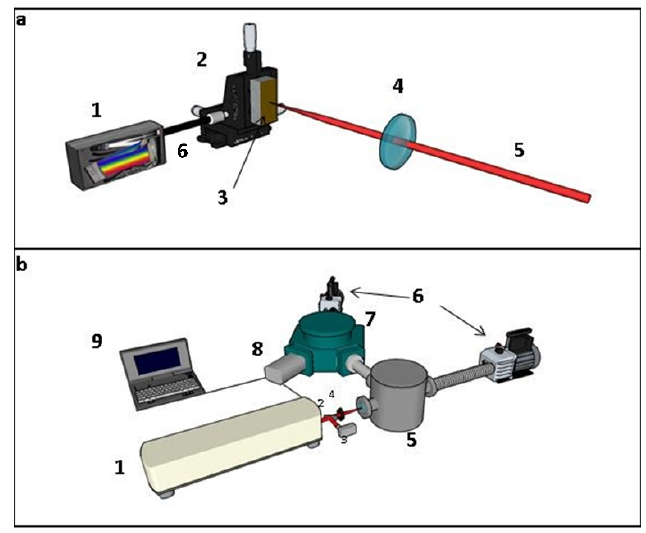
Figure 1. Experimental setups used: ( a ) 1: UV-VIS-NIR spectrograph, 2: XYZ translation stage, 3: sample, 4: focusing optics, 5: laser beam, 6: fiber bundle; ( b ) 1: Nd: YAG laser, 2: beam splitter 3: laser energy meter, 4: focusing optics, 5: vacuum chamber, 6: vacuum pump 7: vacuum ultraviolet (VUV) spectrograph, 8: CCD detector, 9: PC for data acquisition.